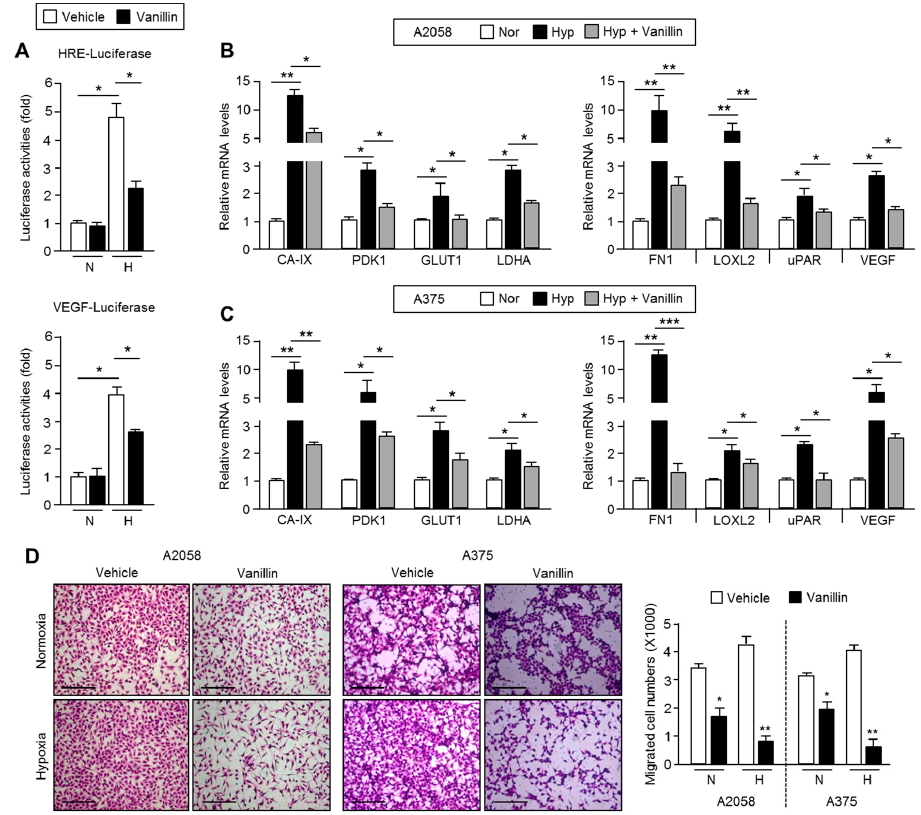
Figure 5. Vanillin inhibits HIF-1 α transcriptional activity and cell motility in malignant melanoma cells. ( A ) Inhibitory effect of vanillin on HIF-1 α transcriptional activity. A2058 cells were